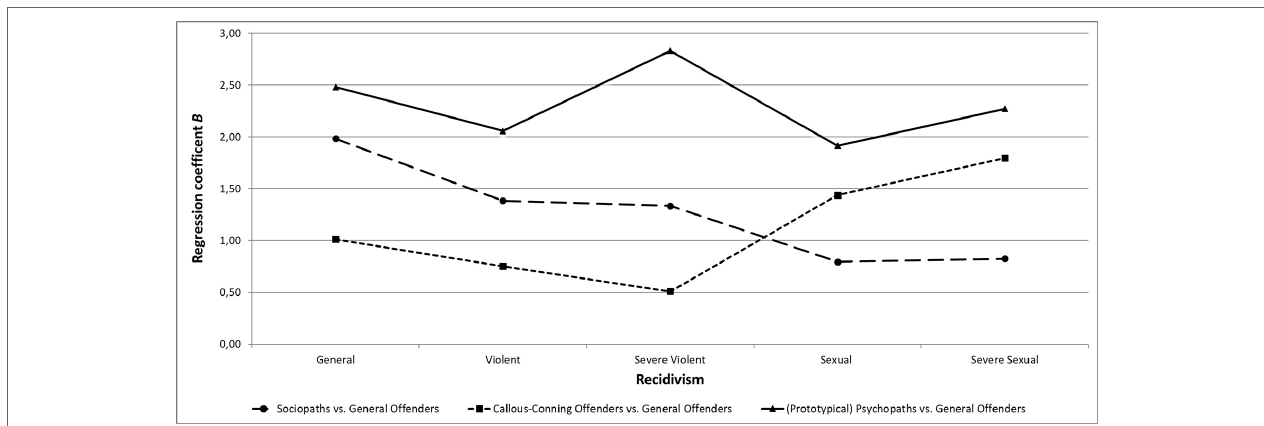
FIGURE 2 | Recidivism risk profiles for psychopaths, sociopaths, and manipulative offenders compared to general offender for general, violent, severe violent, sexual, and severe sexual